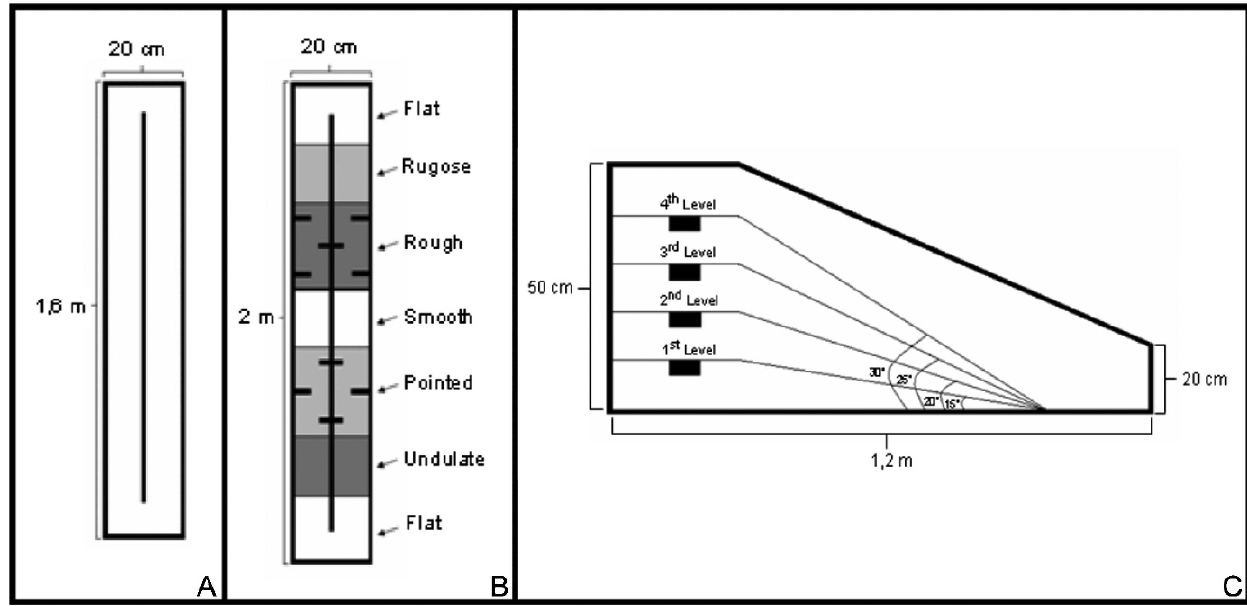
Figure 1 - Apparatuses where the animals were trained. (A) Runway apparatus with measures. (B) Maze apparatus with measures and indication of different textures. (C) Ramp apparatus with measures and indication of four